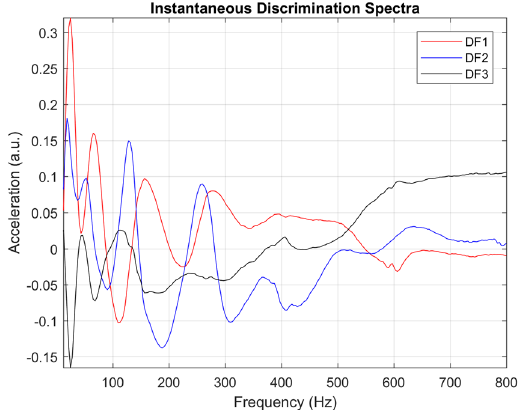
Figure 2. The optimised instantaneous discrimination spectra (DF1, DF2 and DF3) as defined by the DFA algorithm. Frequency along the X-axis is cropped between 18 and 800 Hz; the Y-axis shows the logarithm of acceleration. High (positive or negative) acceleration values indicate spectral areas of particular importance to swarming prediction, whilst low values, approaching zero, correspond to vibrational frequencies which must be dismissed. This figure was created using the MATLAB (R2018b) software (uk.mathworks.com).